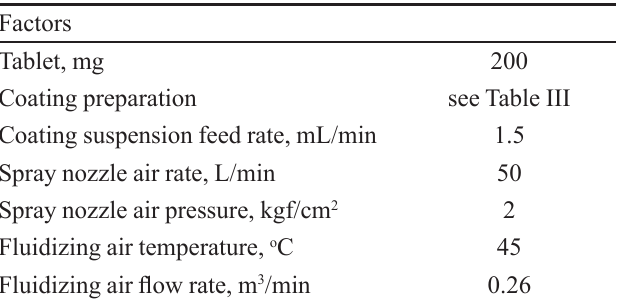
TABLE IV - Operational conditions for fluid bed coating of feverfew